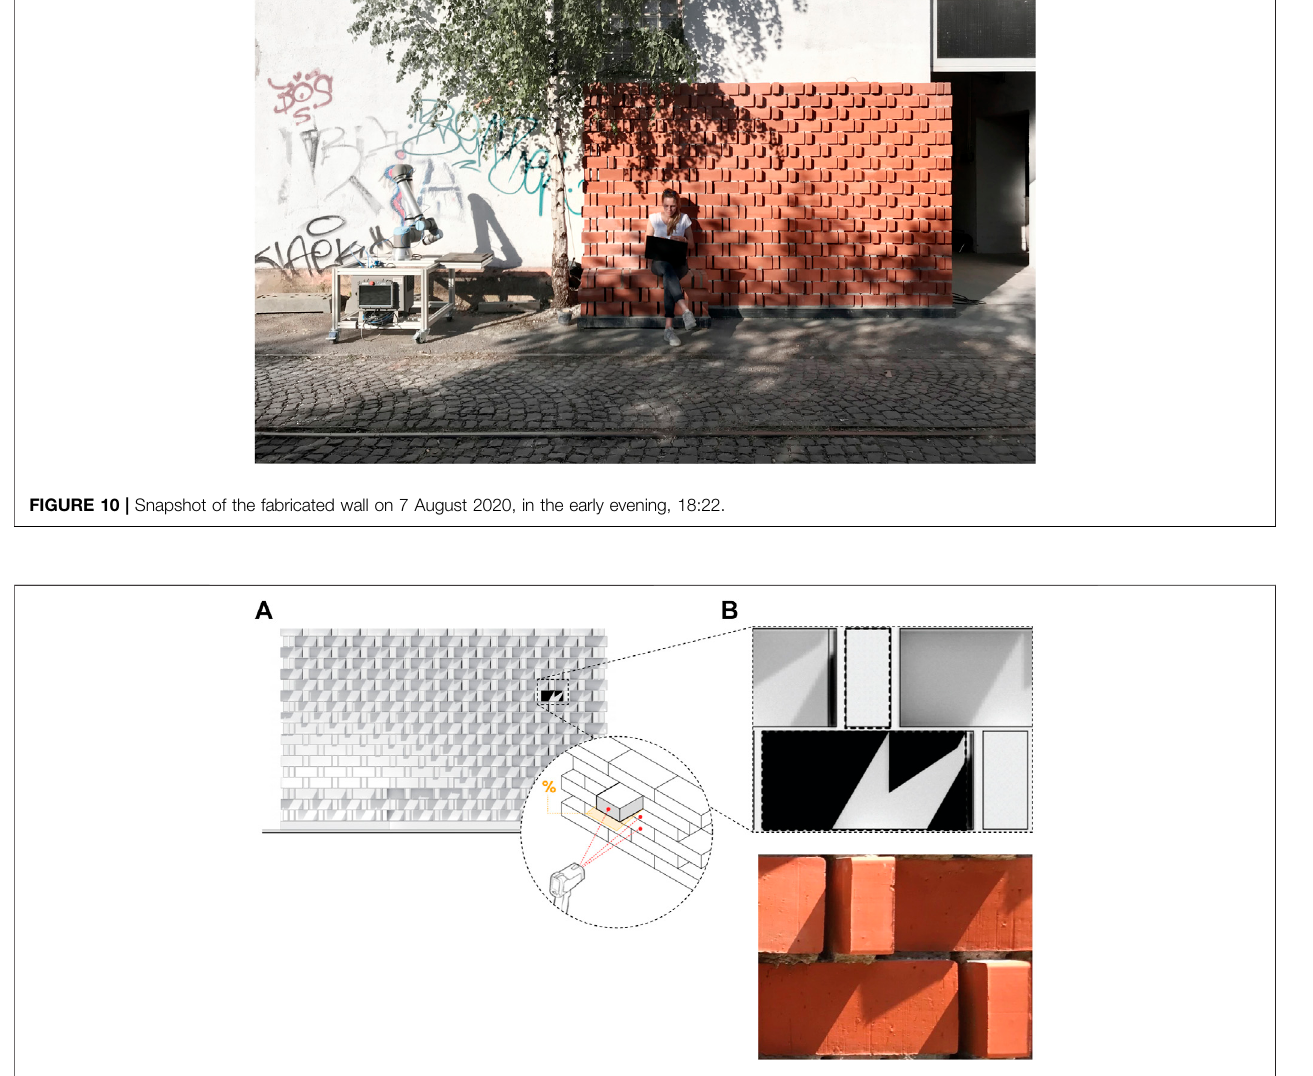
FIGURE 11 | comparison of cast shadow: The simulation shows the self-shading effect on protruding geometries in the wall (A) with the identic image (B) on August 7th,12:30 h.Theblackcoloredshinerin (A) shows53%ofshaded surfaceareaforthetimewiththehighestincidentofsolarradiationwhichleadstoareduction of solar